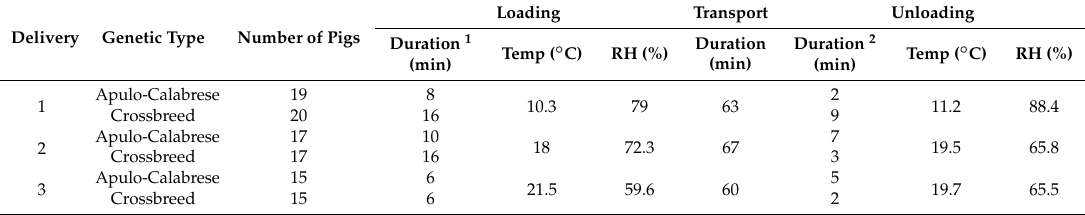
Table 1. Outdoor temperature (Temp), relative humidity (RH), and durations of loading, transport and unloading recorded in pigs in the three